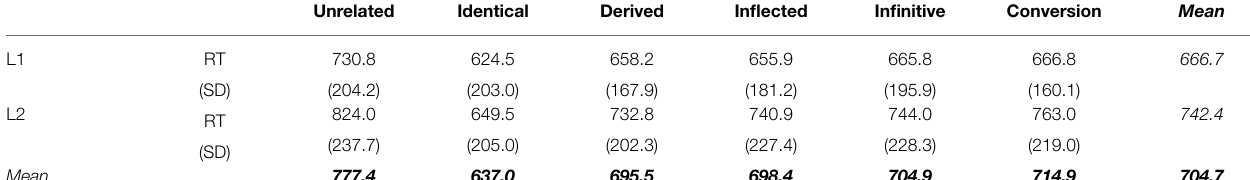
TABLE 8 | Experiment 4: mean reaction times for target phrases in ms, standard deviations (in